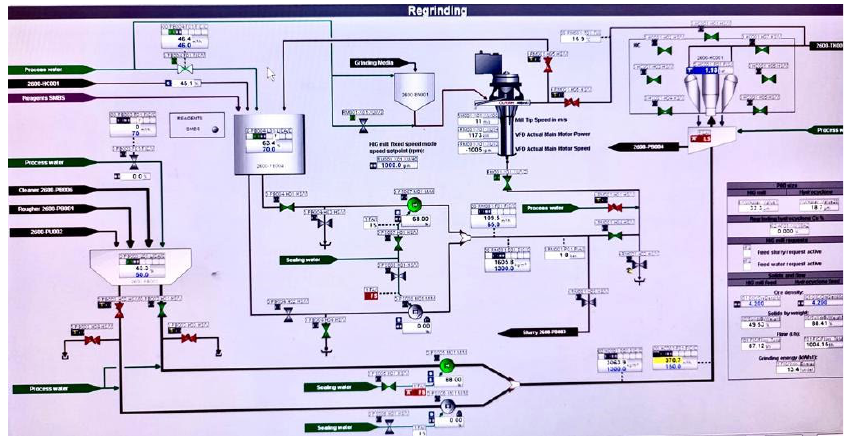
Figure 5. Screenshot of the expert system of HIGMill operation.